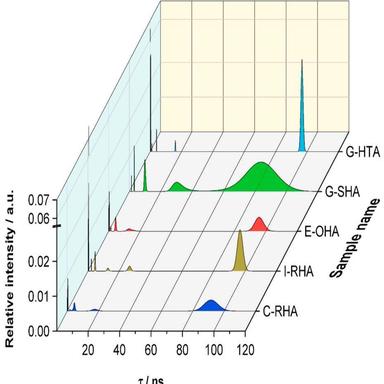
Lifetime distributions as obtained by PALS; C-/I-RHA: rice husk ash (Cambodia/Italy), E-OHA: oat husk ash (Europe), G-SHA: spelt husk ash (Germany), G-HTA: horsetail ash (Germany).